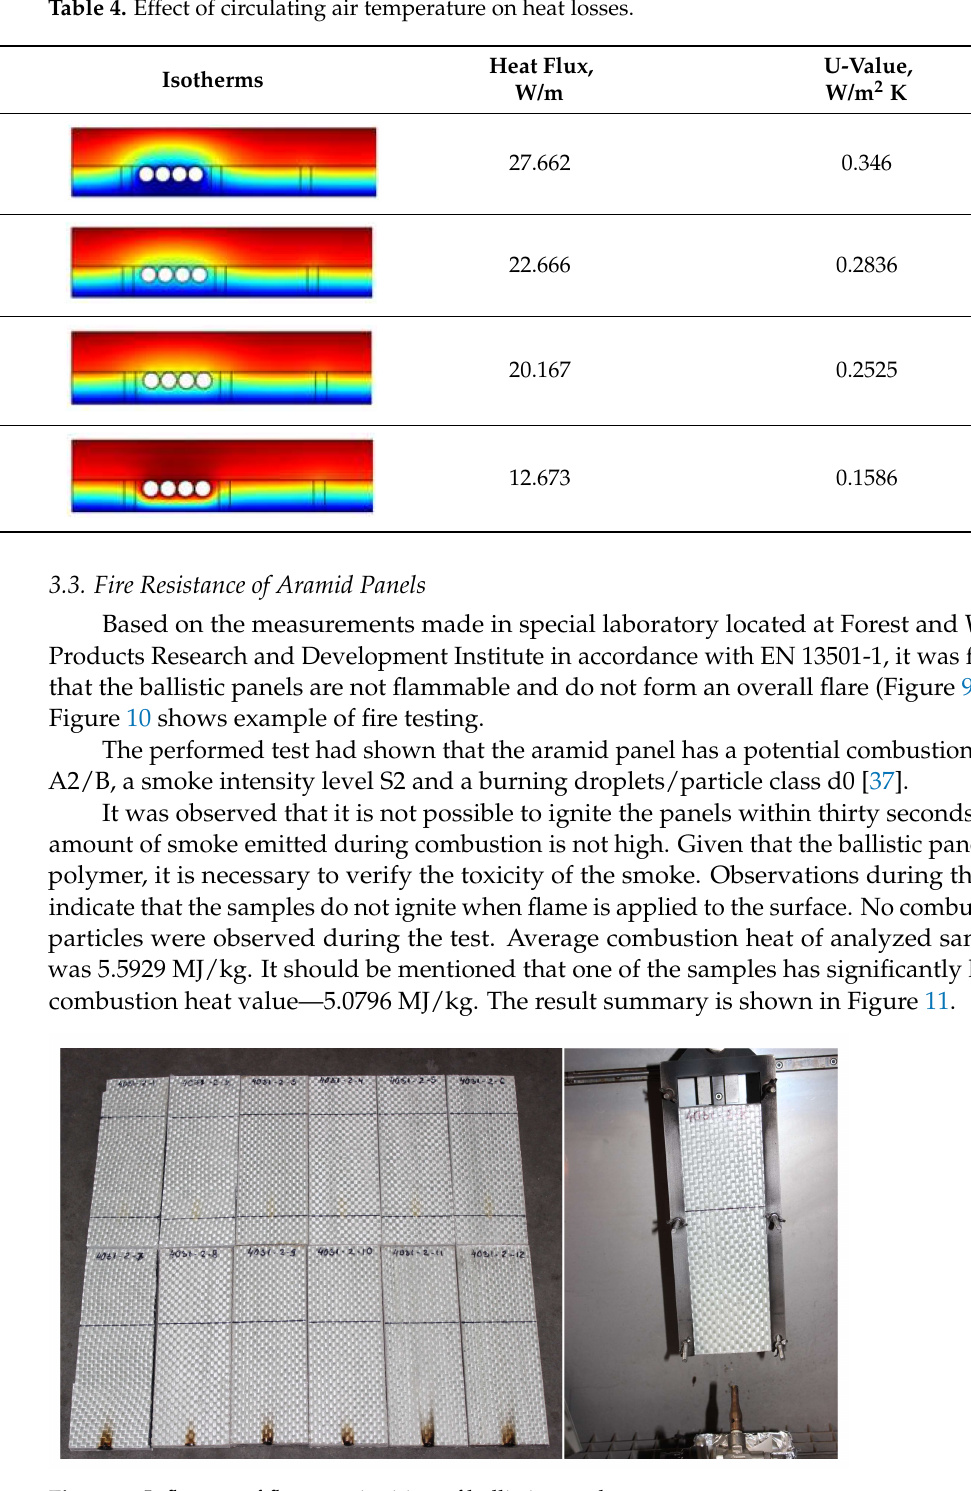
Figure 9. Influence of flame on ignition of ballistic